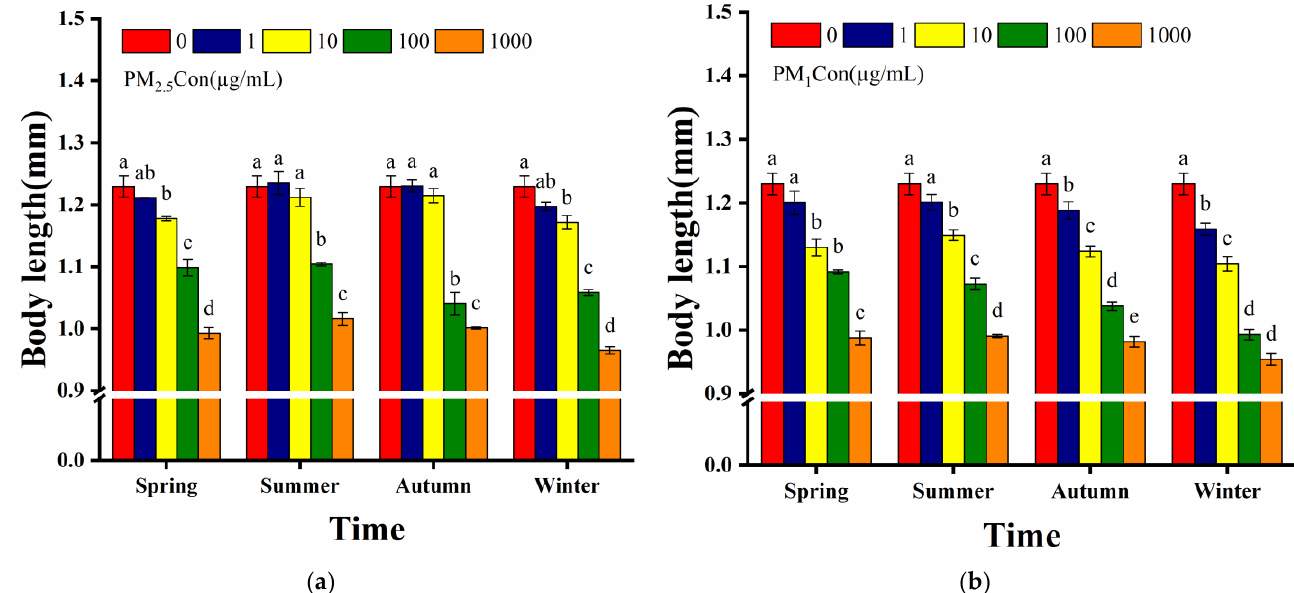
Figure 3. Effect of different seasons of PM exposure on nematode body length: ( a ) body length of nematodes exposed to 1, 10, 100 and 1000 µg/mL of PM 2.5 in four seasons compared to the control; ( b ) body length of nematodes exposed to 1, 10, 100 and 1000 µg/mL of PM 1 in four seasons compared to the control. L4 stage larvae were selected for 24 h acute exposure. Different letters (a, b, c, d, e) indicate significant differences among the five PM treatments in each season ( p < 0.05). Bars represent means ± SEM.